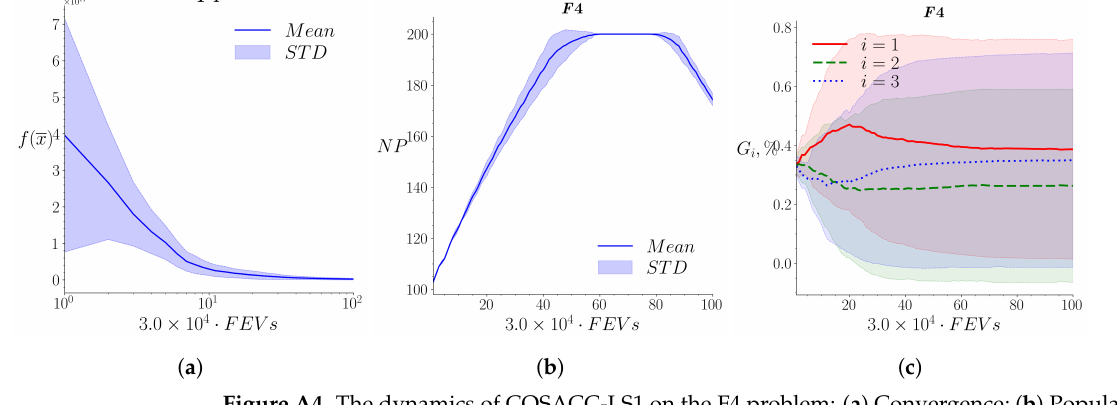
Figure A4. The dynamics of COSACC-LS1 on the F4 problem: ( a ) Convergence; ( b ) Population